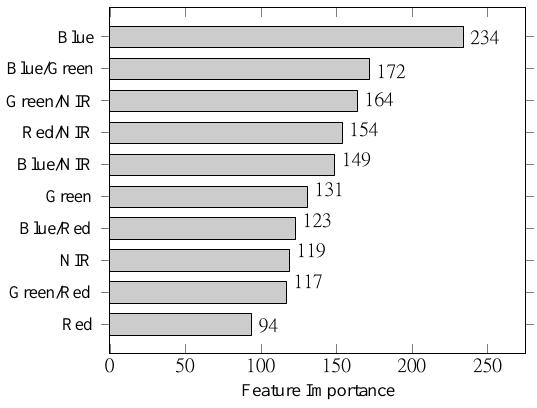
Figure 5. Important Features in the LightGBM Model. The Blue band has the largest effect on Chl-a concentration, followed by the band ratios Blue/Green and